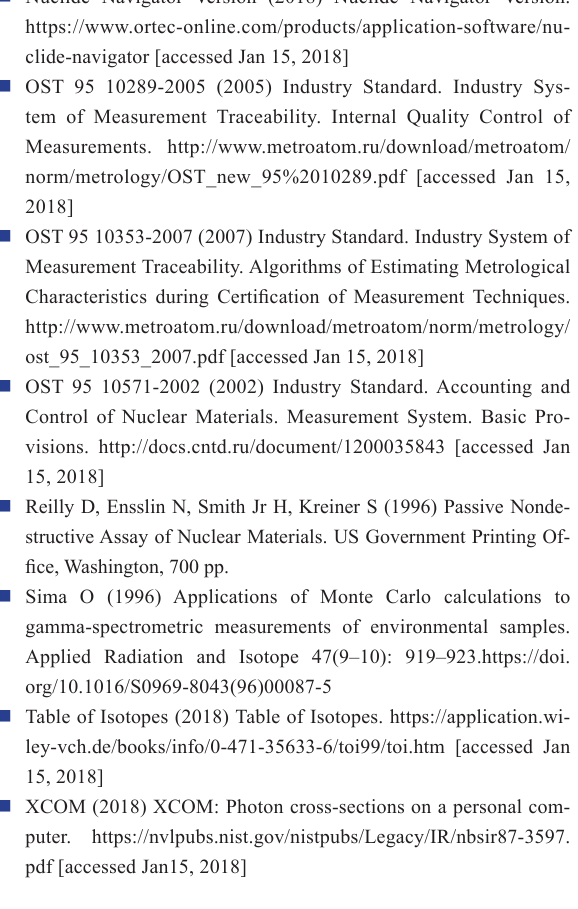
 Table of Isotopes (2018) Table of Isotopes.